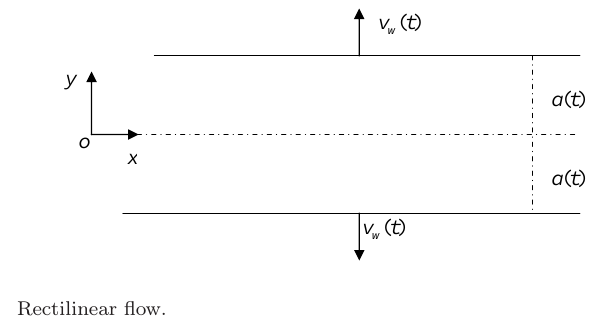
Figure 1. Rectilinear